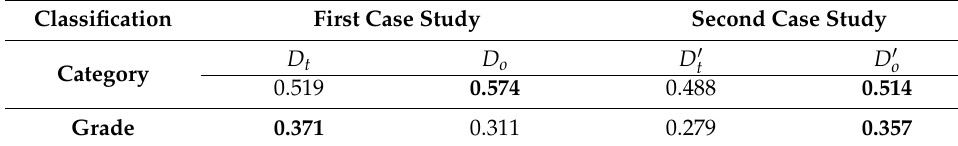
Table 7. Acc values computed for the t-SNE plots from Figures 5 and